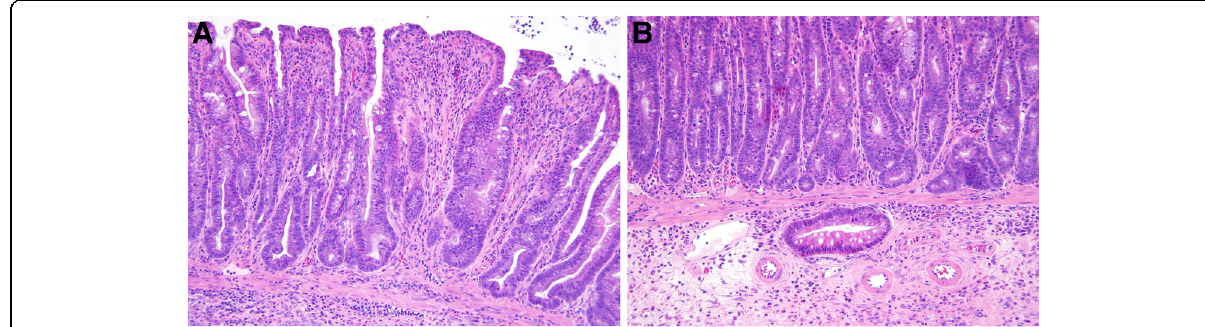
Fig. 8 a Rectal prolapse in mice may mimic adenomatous change, as in humans. Here, note thickened hyperplastic reactive-appearing mucosa, with fibromuscular changes in the lamina propria. b In areas of prolapse, displacement of non-neoplastic crypts may mimic invasive adenocarcinoma. Here,